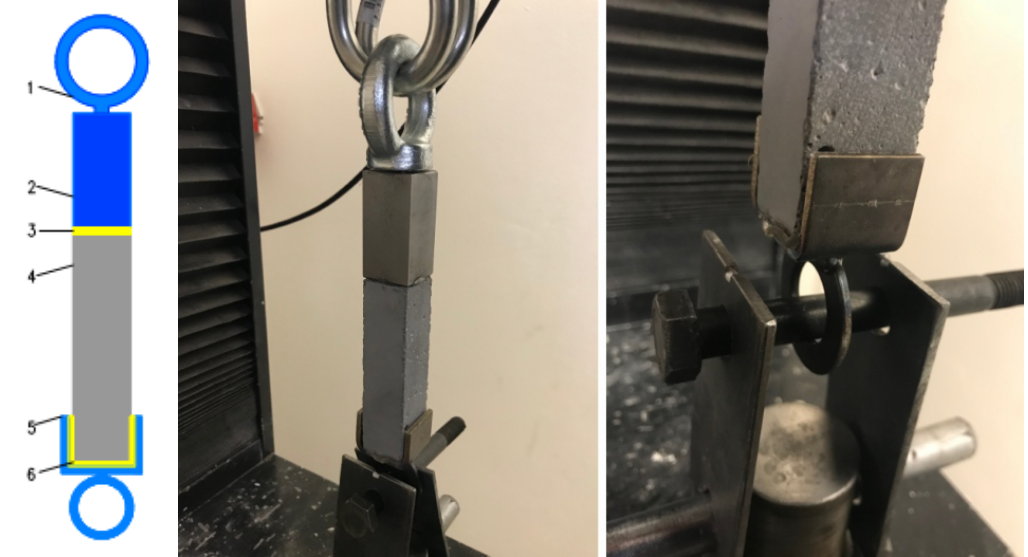
Figure 1. Design of tensile test: 1. Steel sleeve, 2. Steel adherent, 3. Selective glue, 4. HPC adherent, 5. Steel sleeve, 6. Construction glue. View on the real specimen in testing machine.